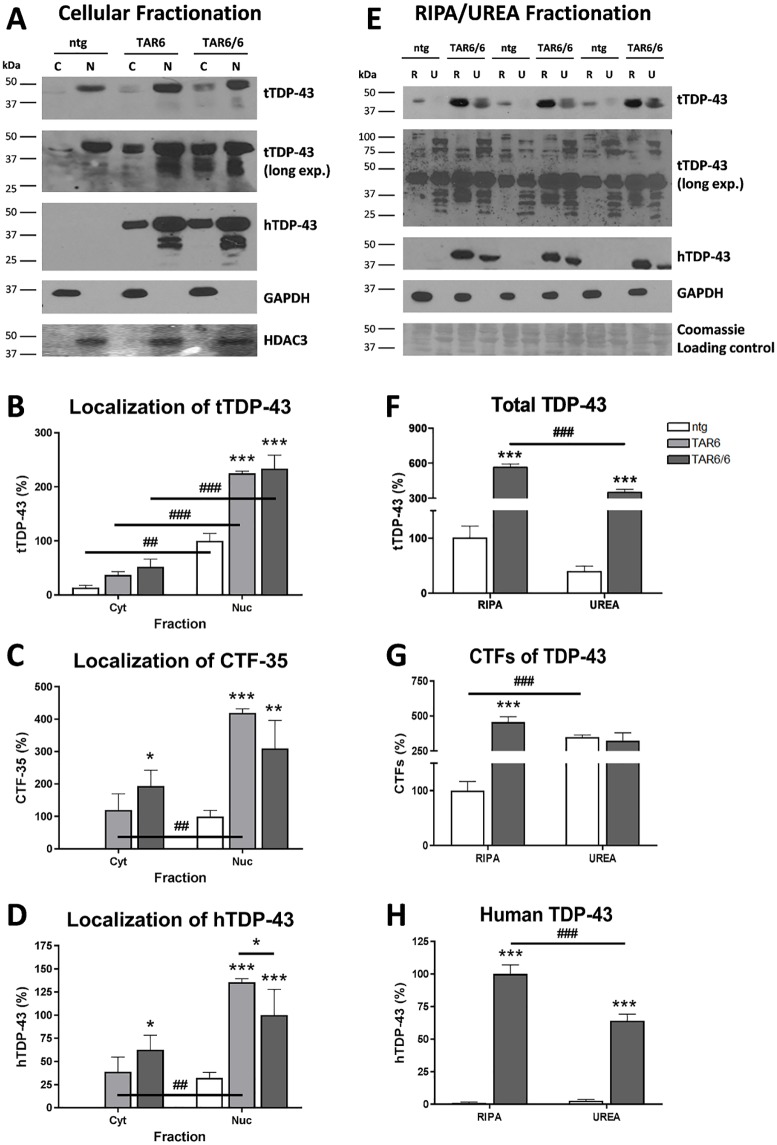
Posttranslational changes in TAR6/6 mice.(A-D) Localization of tTDP-43, CTF-35 and hTDP-43 after cellular fractionation of 3 months old TAR6/6 mice. (A) Cell fractions of midbrain and cortex samples of 3 months old ntg, TAR6 and TAR6/6 mice were analyzed by Western blotting and probed with the indicated antibodies (GAPDH as cytoplasmic and HDAC3 as nuclear marker; long exp. = long time ECL exposure for 30 min). One representative example of 4 is shown (C: cytoplasm, N: nucleus). (B- D) Densitometric analysis of tTDP-43, CTF-35 and hTDP-43 levels in cell fractions (cyt: cytoplasm, nuc: nucleus). Nuclear tTDP-43 and CTF-35 levels of ntg and hTDP-43 of TAR6/6 were set as 100%. (E-H) Soluble and insoluble TDP-43 protein levels in brains of 3 months old TAR6/6 mice. Brain samples were separated into RIPA soluble (R) and RIPA insoluble / UREA fractions (U). Three representative examples of 5 are shown. Fractions were analyzed by Western blotting and probed with the indicated antibodies (long exp. = long time ECL exposure for 30 min). Coomassie Blue staining was performed as loading control for UREA fraction. (F-H) Densitometric analysis of tTDP-43, CTFs and hTDP-43 levels in RIPA and UREA fractions. For tTDP-43 and CTF evaluation, RIPA fraction of ntg was set as 100%, whereas for hTDP-43 analysis, RIPA sample of TAR6/6 was set as 100%. (B-D; F-H) Two-way ANOVA followed by Bonferroni‘s post-hoc test. Mean+SEM. *significances between genotypes, #significances between fractions. *p<0.05, **p<0.01, ***p<0.001.